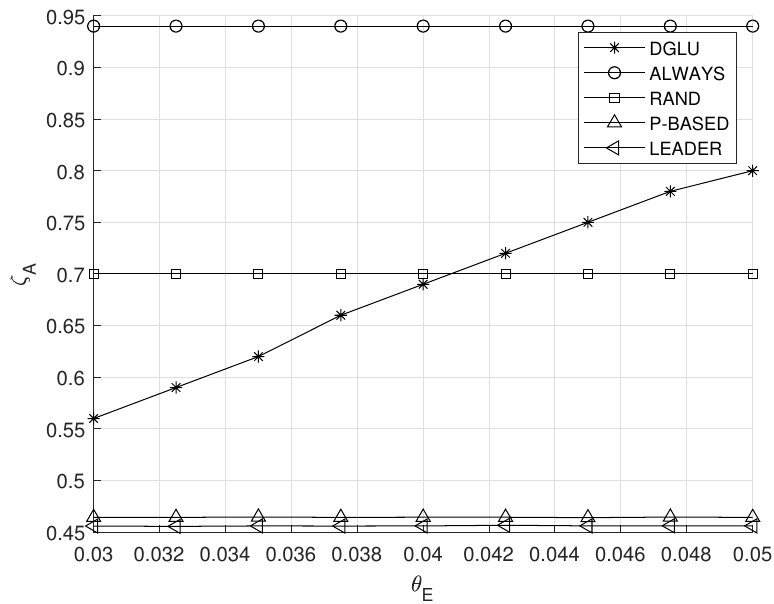
Figure 7. Effect of the target energy outage probability θ E on the average location accuracy ζ A